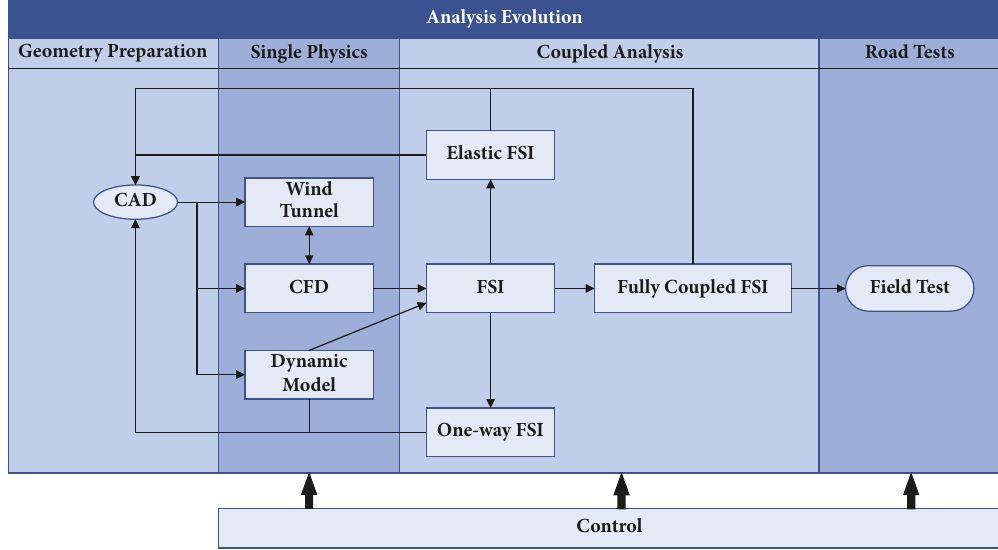
Figure 1: Scheme of the data flow in the project of vehicle active aerodynamic safety, where CAD is computer aided design, CFD is computer fluid dynamics, and FSI is fluid structure